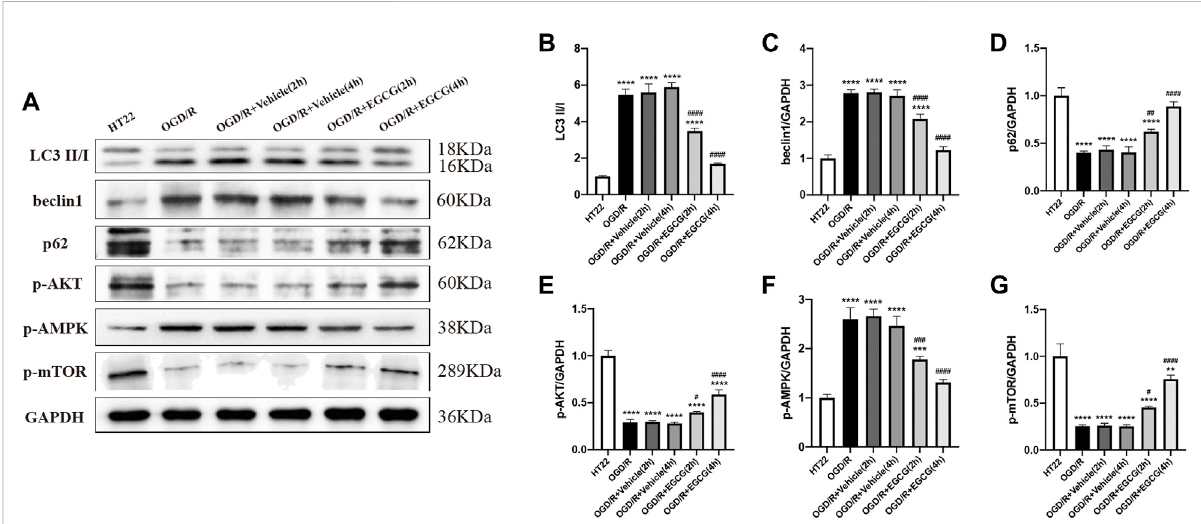
FIGURE 6 EGCG suppressed autophagy and modulated the AKT/AMPK/mTOR phosphorylation pathway in oxygen-glucose deprivation/reperfusion (OGD/R)-challenged HT22 cells. (A) The expression of LC3 II/I (B) , beclin1 (C) , p62 (D) , p-AKT (E) , p-AMPK (F) , and p-mTOR (G) was assessed by Western blotting assay. Each experimental datum was presented as mean ± standard deviation ( n = 3 per group). ** p < 0.01, *** p < 0.001, **** p < 0.0001 versus HT22 group, # p < 0.05, ## p < 0.01, ### p < 0.001, #### p < 0.0001 versus OGD/R